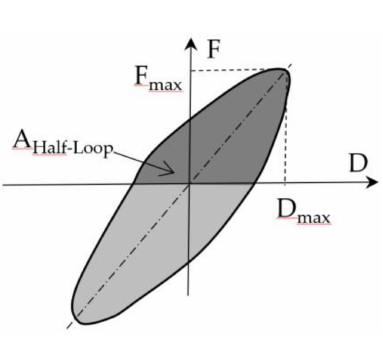
Figure 13. Example of damping determination for a hysteretic force (F) displacement (D) half-cycles. The cumulative energies ( Σ E i d ) calculated for the ASB and the RR columns for the negative and the positive half loops were obtained as the sum of the dissipated energy E i displacement history, and are given in Figure